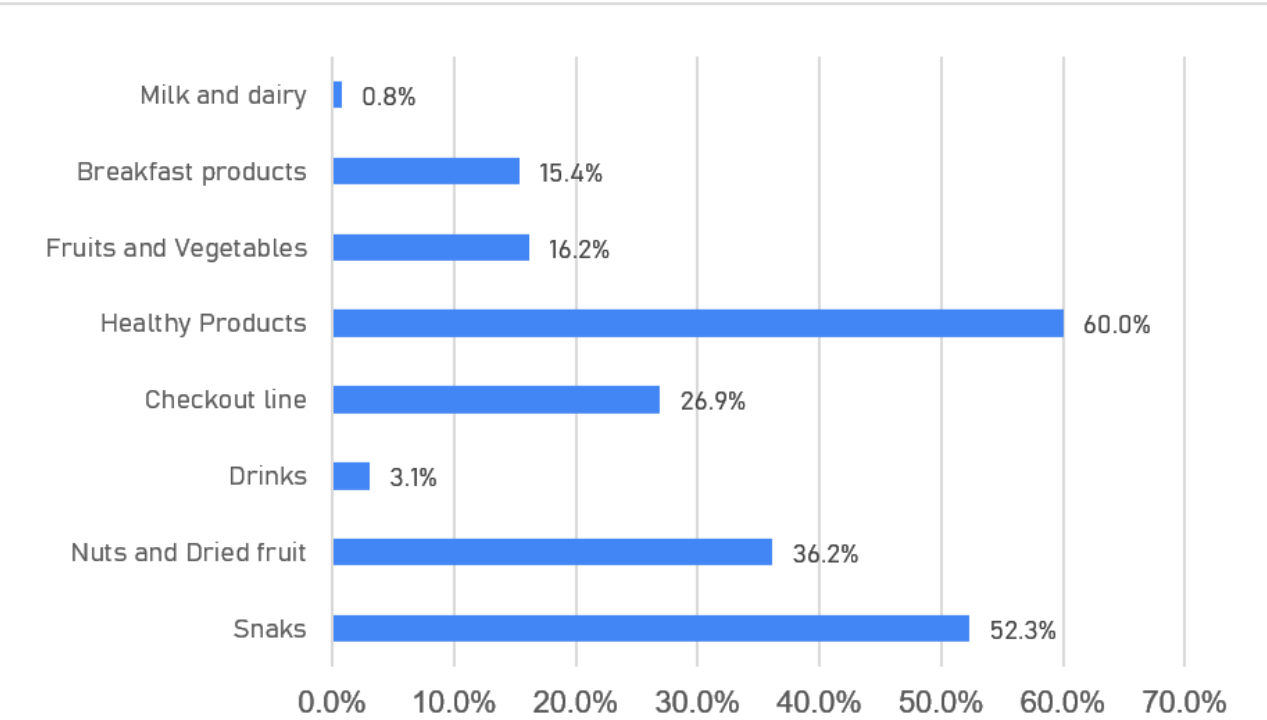
Figure 5. Healthy snack allocation within the supermarket.